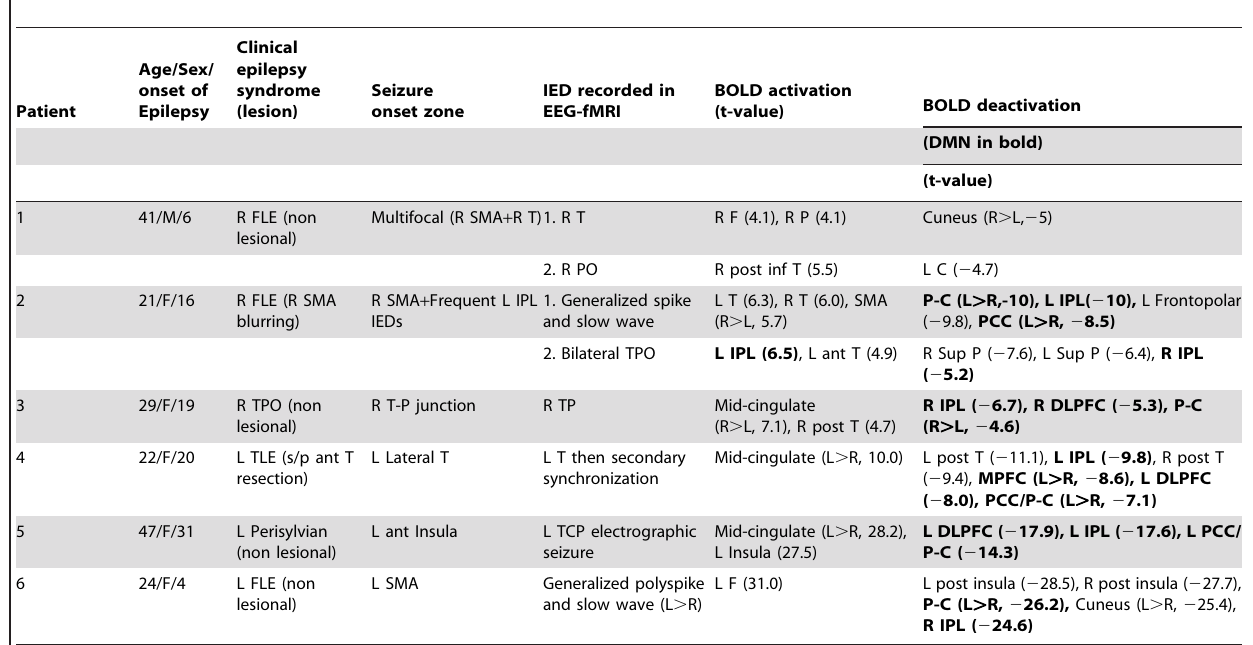
Table 1. Patient clinical data and main EEG-fMRI findings